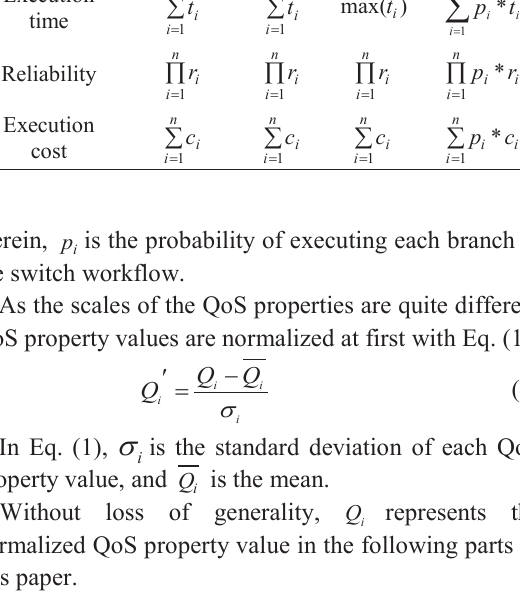
Table 1. Aggregation function of QoS properties QoS property Sequential Loop Parallel Switch Execution